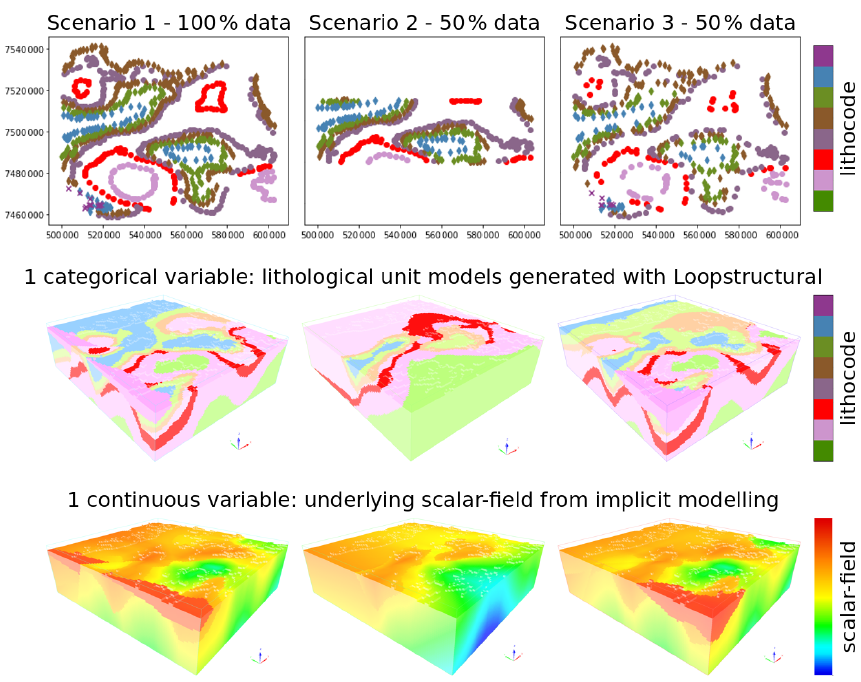
Figure 5. Example model set of lithocode and scalar fields for each of the three scenarios; the left column illustrates input data and model set for scenario 1 when all data are considered; the middle column illustrates input data and model set for scenario 2 when 50% of the data within a band are considered; the right column illustrates input data and model set for scenario 3 where each input data are decimated with a probability of